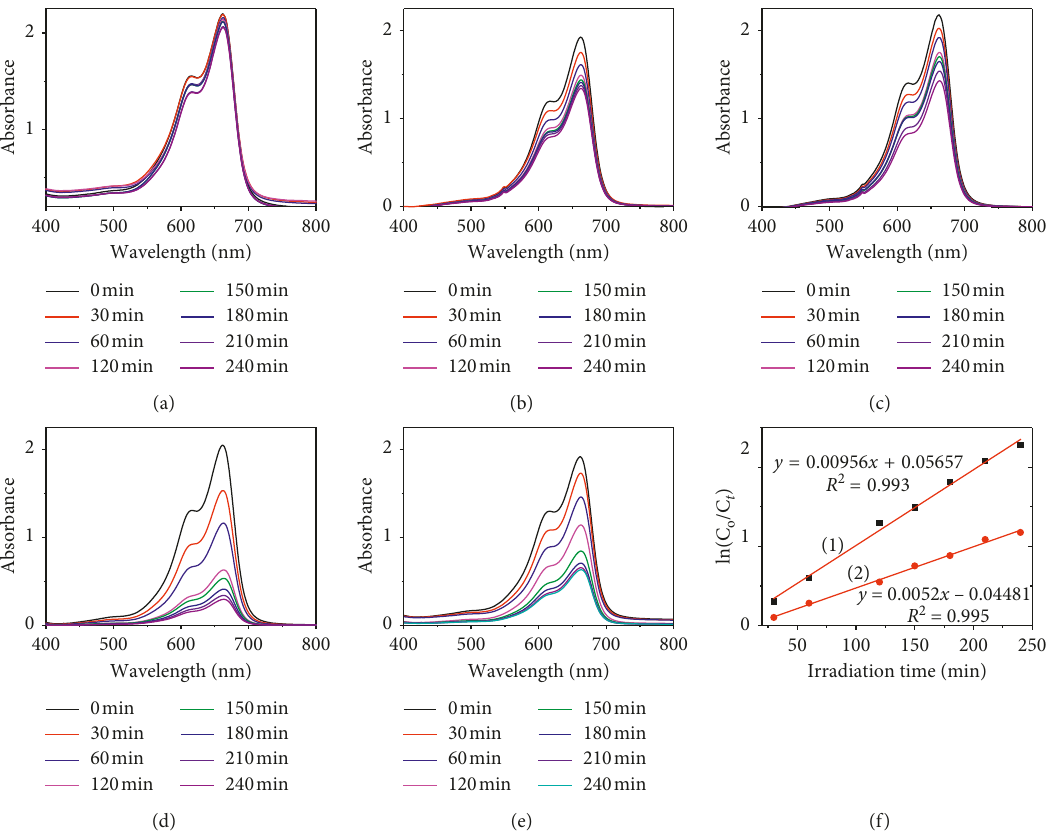
Figure 6: UV-Visible spectra of MB in different conditions and calcination temperatures of MgFe 500 ° C+ light, (c) 500 ° C +H 2 O 2 + dark, (d) 500 ° C+H 2 O 2 +light, (e) 600 ° C +H 2 O 2 +light, and (f) the plots of ln ( C o /C t ) versus irradiation time ( t ) in the presence of MgFe 2 O 4 calcined samples at 500 ° C (1) and 600 ° C ( k ) for the MgFe 2 O 4 samples calcined at 500 ° C and 600 ° C were 0.00956 min 1 and 0.0052 min 1 , respectively.